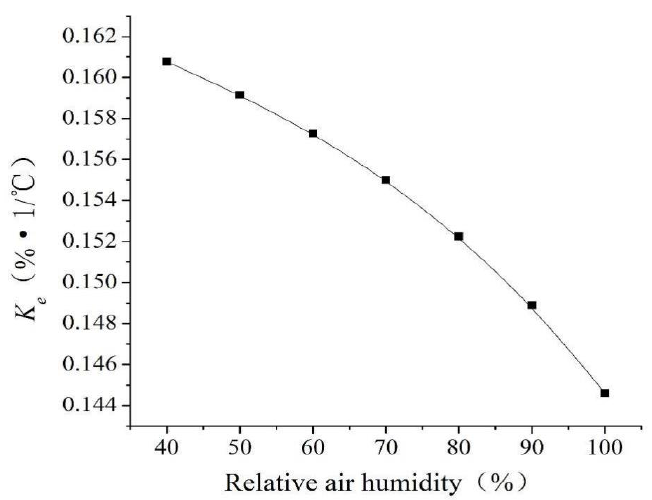
Figure 11. Relationship between K e and relative air humidity.